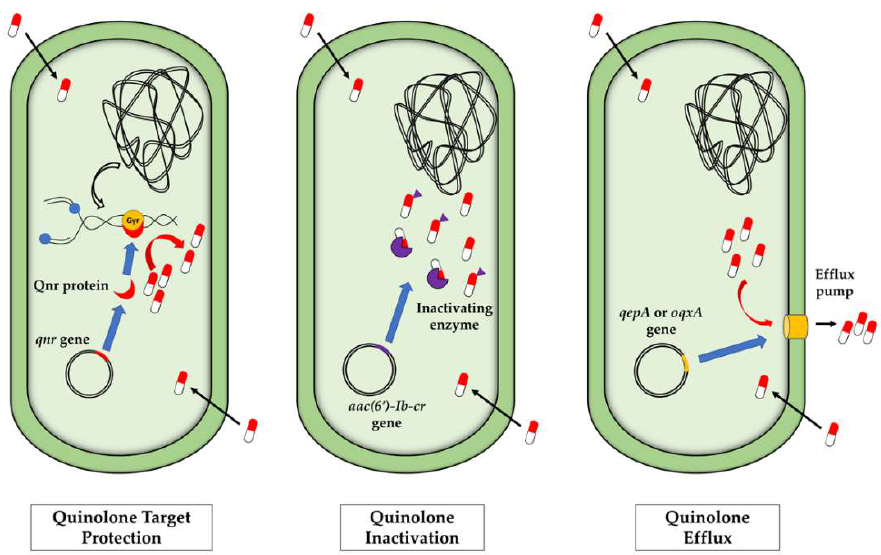
Figure 1. Mechanisms of action of plasmid-mediated quinolone resistance (PMQR)